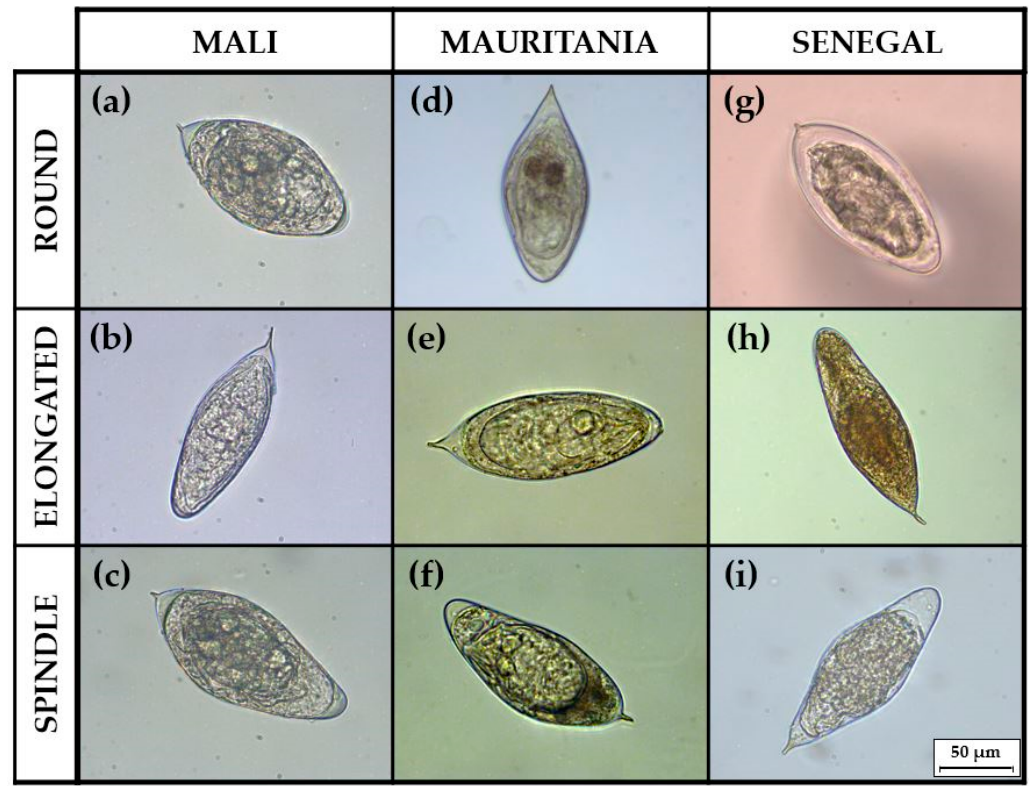
Figure 5. Representative egg samples of the different morphotypes from each country: ( a ) round, ( b ) elongated, and ( c ) spindle eggs from Mali; ( d ) round, ( e ) elongated, and ( f ) spindle eggs from Mauritania; ( g ) round, ( h ) elongated, and ( i ) spindle eggs from Senegal. Table 3. Measurements of S. haematobium eggs grouped by country of origin. Mean ± SD